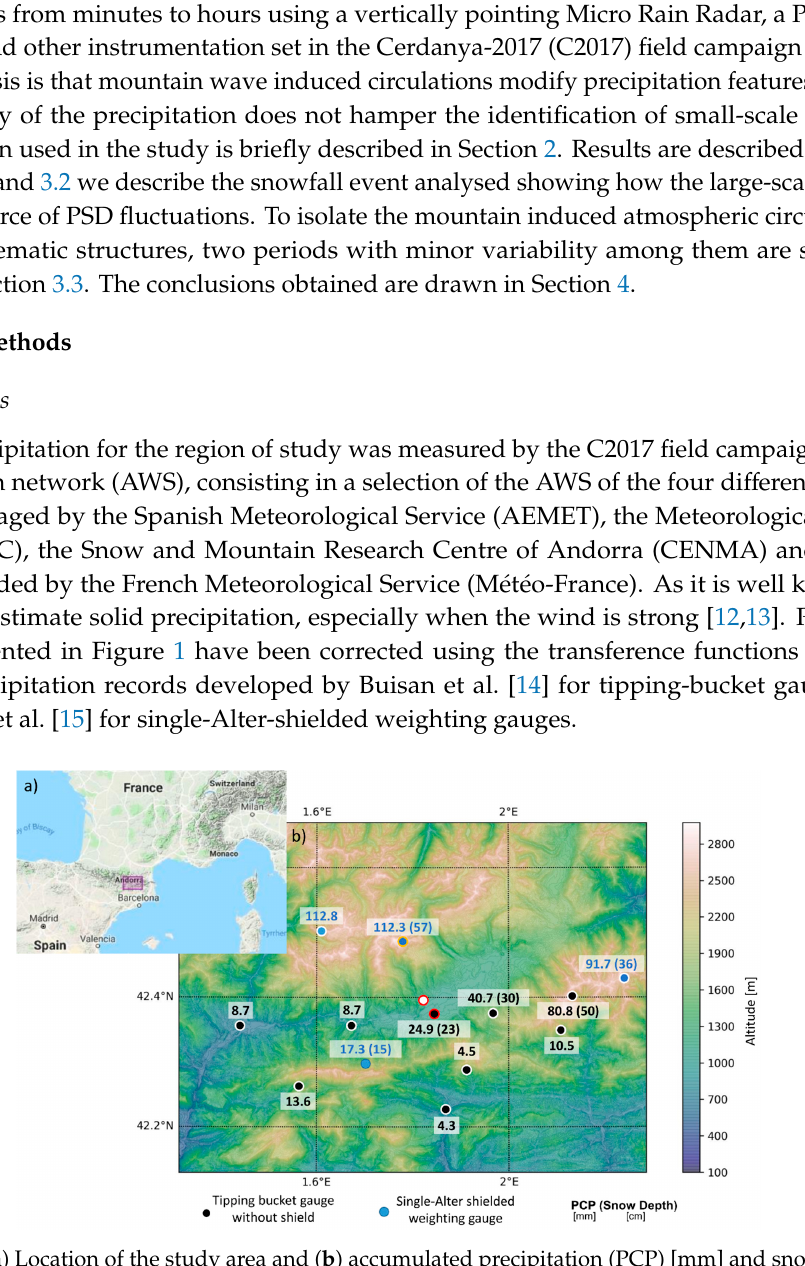
Figure 1. ( a ) Location of the study area and ( b ) accumulated precipitation (PCP) [mm] and snow depth increment [cm] (in parentheses, if available) from 15 to 16 January 2017, showing the locations of single-Alter shielded weighting gauges (blue solid circles), tipping bucket heated gauges (black solid circles), Das station where the Micro Rain Radar (MRR) and the Parsivel disdrometer were located (back circle with red contour), the location of Malniu station (blue circle with orange contour) and the location of the UHF wind profiler (white circle with red contour). Precipitation amounts are corrected for undercatch wind e ff ects (see text for